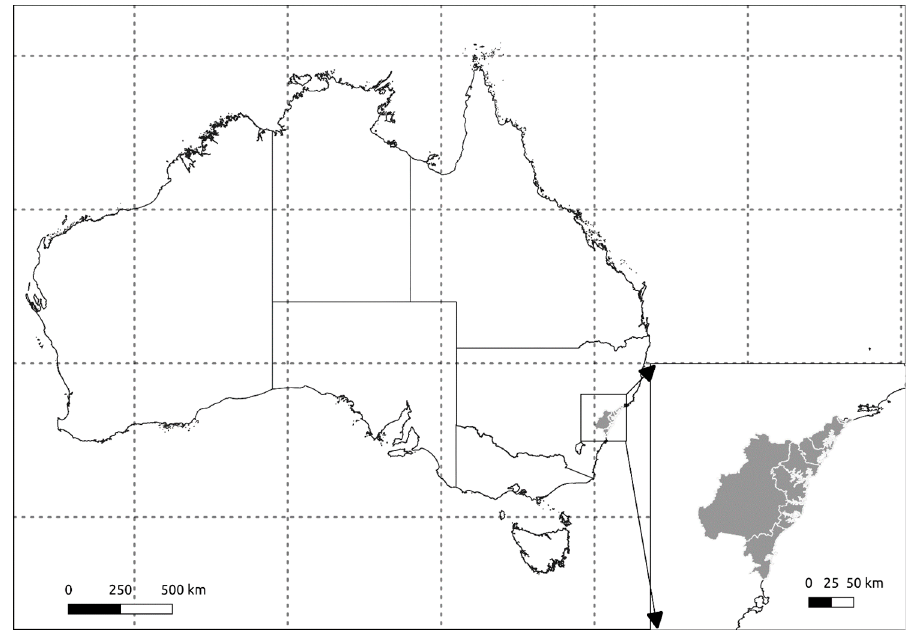
Figure 1. The location and Climate Zone partitions of the study region of Sydney, NSW, Australia (longitude 151.21° E, latitude 33.87° S).